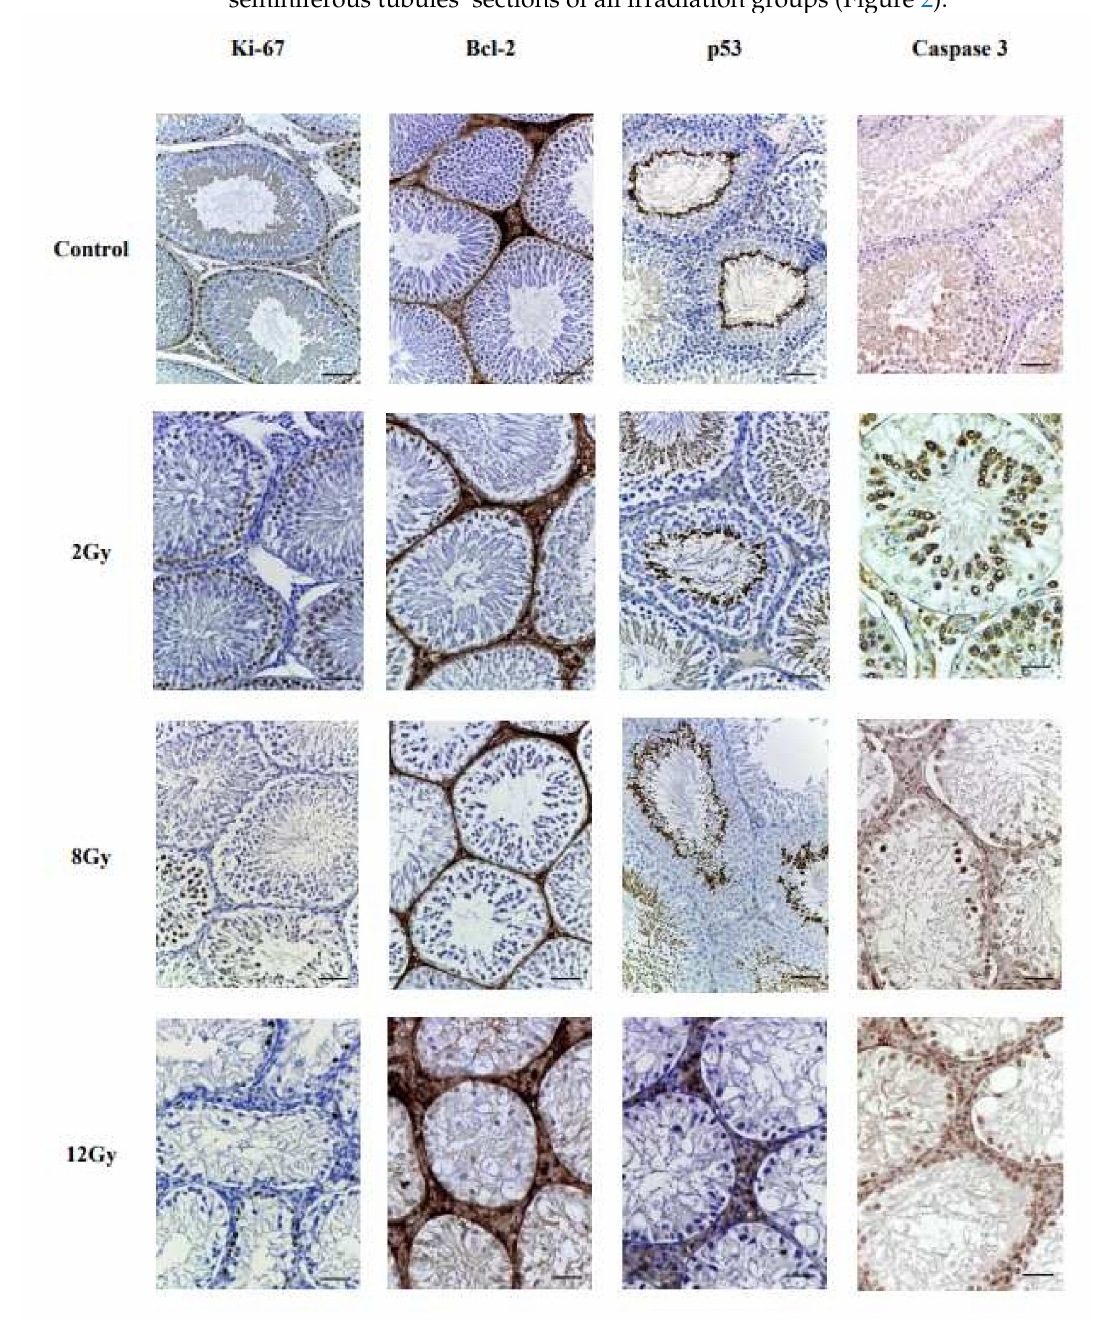
Figure 2. Testes of rats of experimental groups at different radiation doses, IHC staining, magn. × 200. Ki-67-positive reaction in spermatogonia in the 2 Gy irradiation group was 1.2 times less than in the samples of the control group, and the degree of staining tended to decrease in a dose-dependent manner. Moderate marking of gametes was observed in the